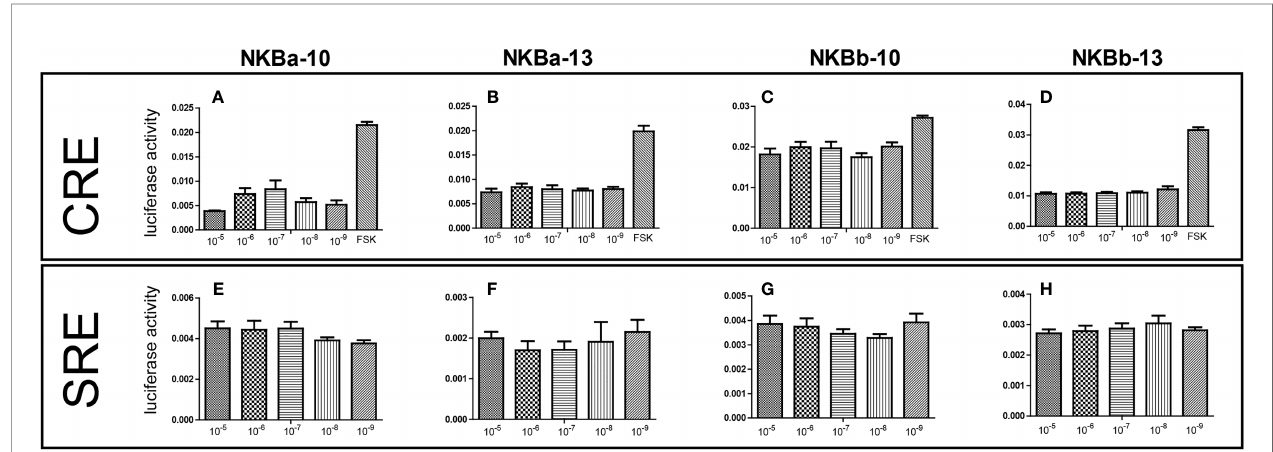
FIGURE 7 | (A – D) NKB peptides induced CRE driven promoter activities co-transfected with Japanese eel tacr3 . (E – H) NKB peptides induced SRE driven promoter activities co-transfected with Japanese eel tacr3